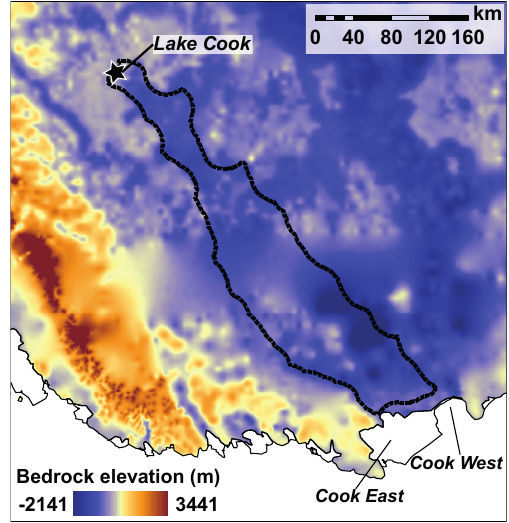
Figure 7. Region of most probable flow path (dashed line) of sub- glacial Lake Cook (Flament et al., 2014) overlain on bed elevation from Bedmap2 (Fretwell et al.,